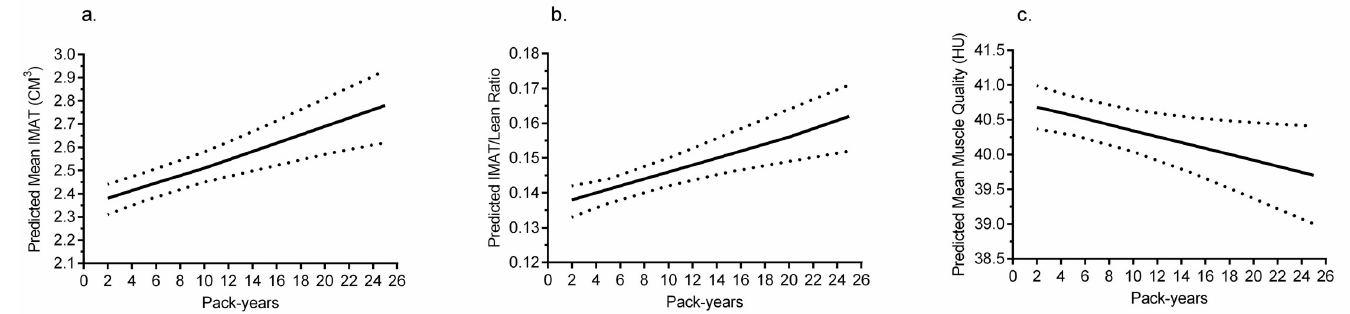
Fig 1. Predicted IMAT volume (cm 3 ), IMAT/lean volume ratio, and lean muscle quality (HU) based on pack-years smoked from CARDIA Y0 through Y25. (a) Predicted IMAT, (b) IMAT/lean ratio, and (c) lean muscle quality are plotted against continuous pack-years during CARDIA adjusted for age, race, sex, center, education, physical activity, alcohol consumption, SSB consumption, FF consumption, BMI, diabetes, cholesterol treatment, hypertension treatment, systolic BP, triglycerides, CRP, prevalent CAC, and VAT/SAT ratio. Pack-years was a significant predictor of IMAT volume ( β [95% CI] 0.017 [0.010–0.025], p < 0.001), IMAT/lean volume ratio ( β [95% CI] 0.001 [0.0006–0.0015], p < 0.001), and lean muscle quality ( β [95% CI] − 0.043 ( − 0.077 to − 0.008], p = 0.016). BP, blood pressure; CAC, coronary artery calcification; CARDIA, Coronary Artery Risk Development in Young Adults; CRP, C-reactive protein; FF, fast food; HU, Hounsfield units; IMAT, intermuscular adipose tissue; SAT, subcutaneous adipose tissue; SSB, sugar-sweetened beverage; VAT, visceral adipose tissue; Y0, baseline; Y25, year 25.